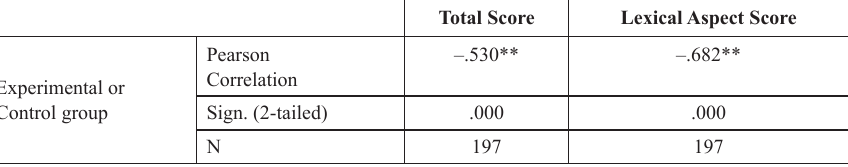
Table 2. Correlation between the writing assignment score (and lexical aspect score in particular) and the students’ affiliation to the experimental or control